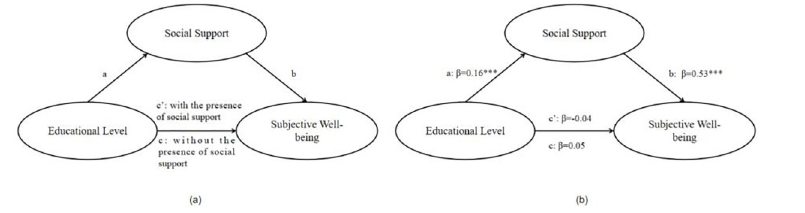
Fig 2. Path coefficients for mediation.